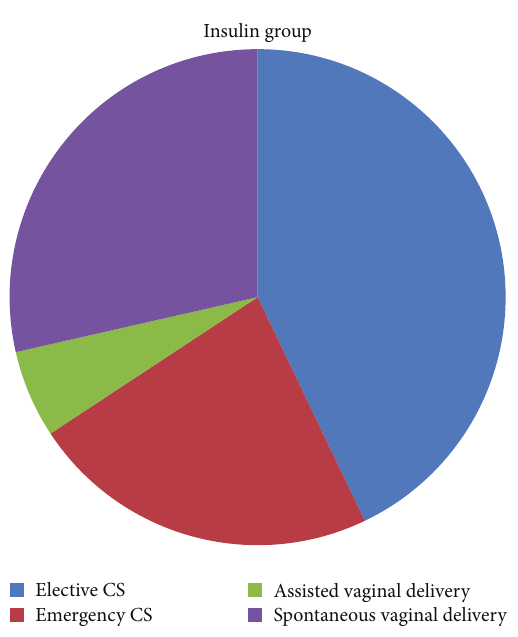
Figure4:Thefigureshows%ofmodesofdeliveriesininsulingroup.